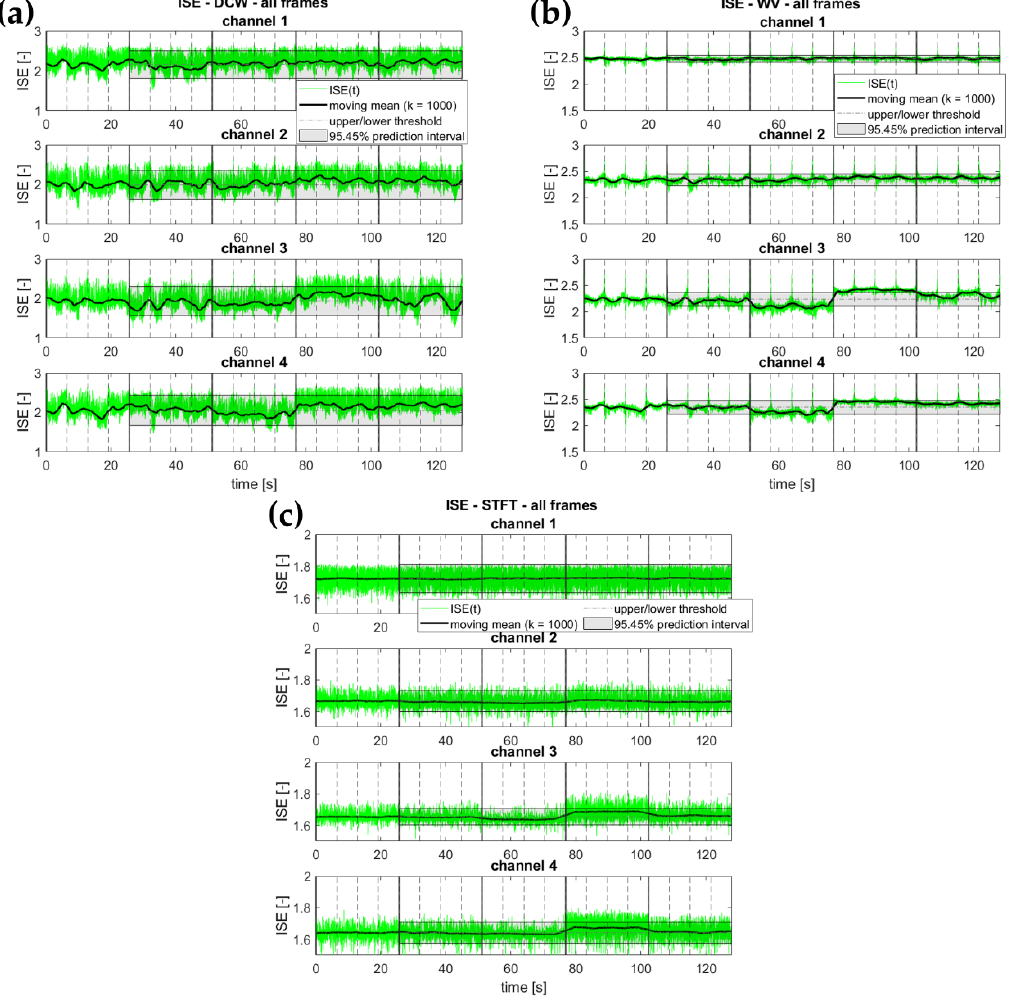
Figure 10. Results for the Rényi entropy of order 2 (collision entropy). ( a ) Discrete Choi–Williams transform. ( b ) Wigner–Ville transform. ( c ) Short-time Fourier transform.